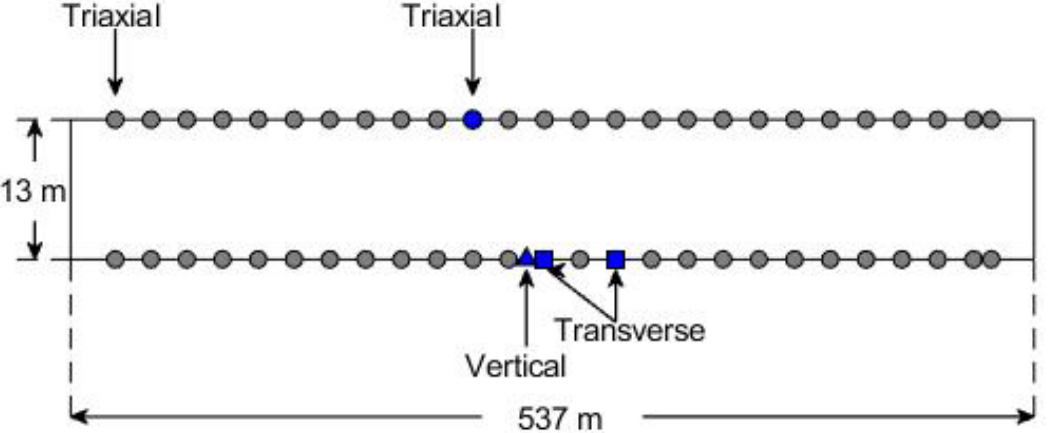
Figure 2. Measured locations in the bridge. Solid grey circles represent the locations of the triaxial sensors measuring along the longitudinal, transverse and vertical direction of the bridge deck. Solid blue circle shows the location of the reference triaxial sensor. Solid blue rectangle denotes the locations of the two uniaxial sensors measuring along the transverse direction. Solid blue triangle denotes the location of uniaxial sensor measuring along the vertical